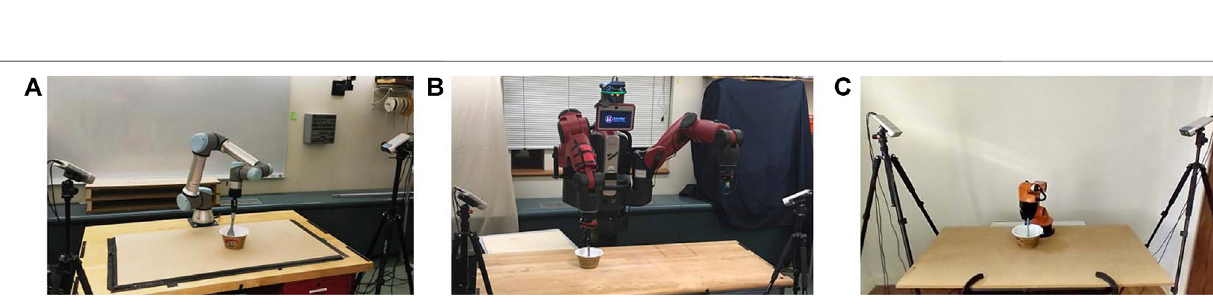
Frontiers in Robotics and AI |